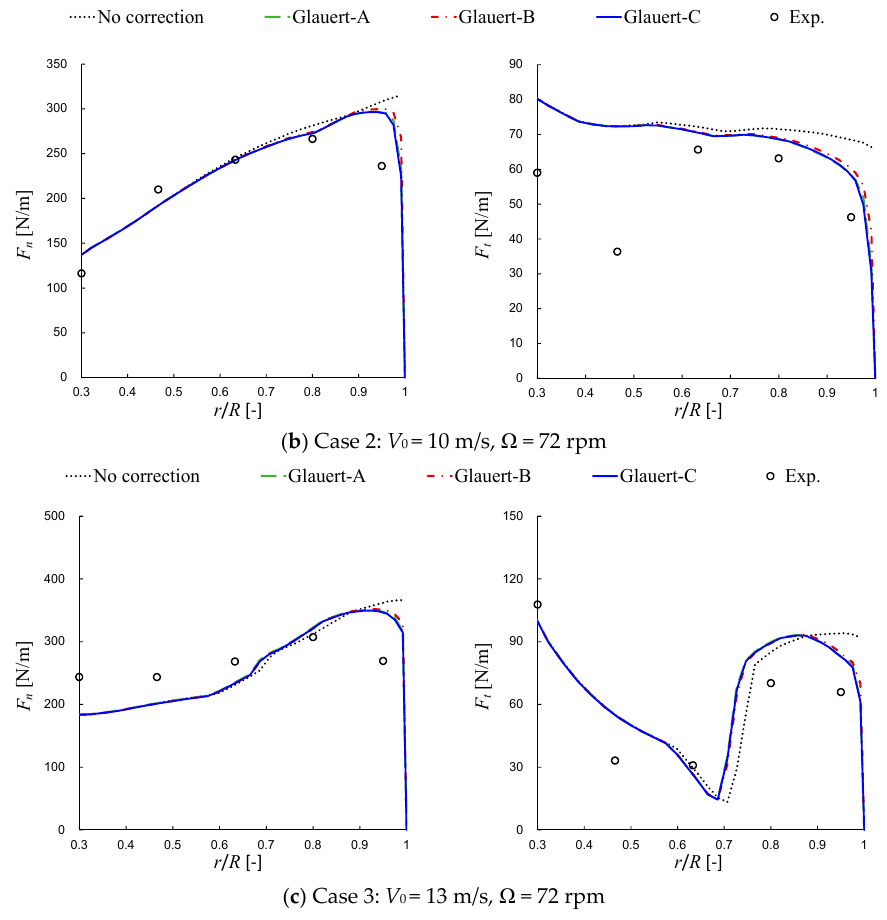
( c ) Case 3: V 0 = 13 m/s, Ω = 72 rpm Figure 4. Normal force n F and tangential force t F along the NREL Phase Ⅵ blade. Figure 4. Normal force F n and tangential force F t along the NREL Phase VI